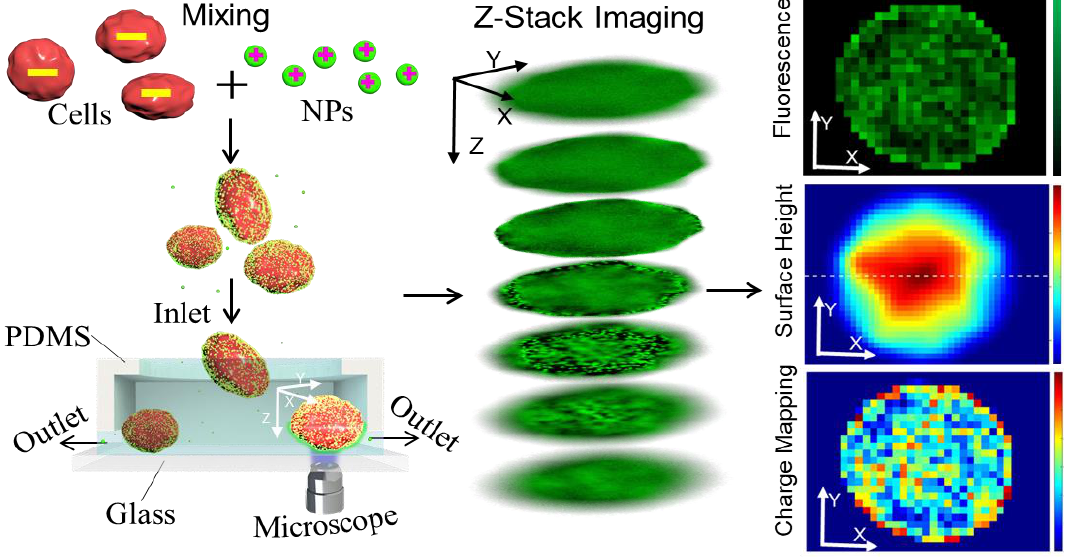
Figure 1. Illustration of the method for a single cell’s surface charge mapping. The cell suspension is mixed with nanoparticles, followed by incubation, washing of unbonded NPs, and capture of cells. The positively charged NPs are attracted onto the wall of the cell due to the electrostatic force. Z-stack images of cells bonded with NPs are captured by a fluorescence microscope, which are processed to map the fluorescence distribution, and thus the surface charge distribution of single